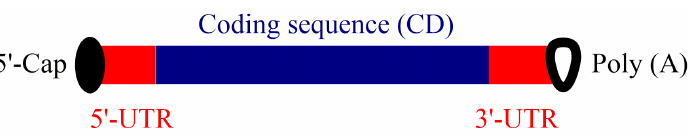
Figure 1. mRNA structure for optimal protein expression in vivo. An improved mRNA candidate contains 5'-cap, poly(A), 5'- and 3'-UTRs, and the coding